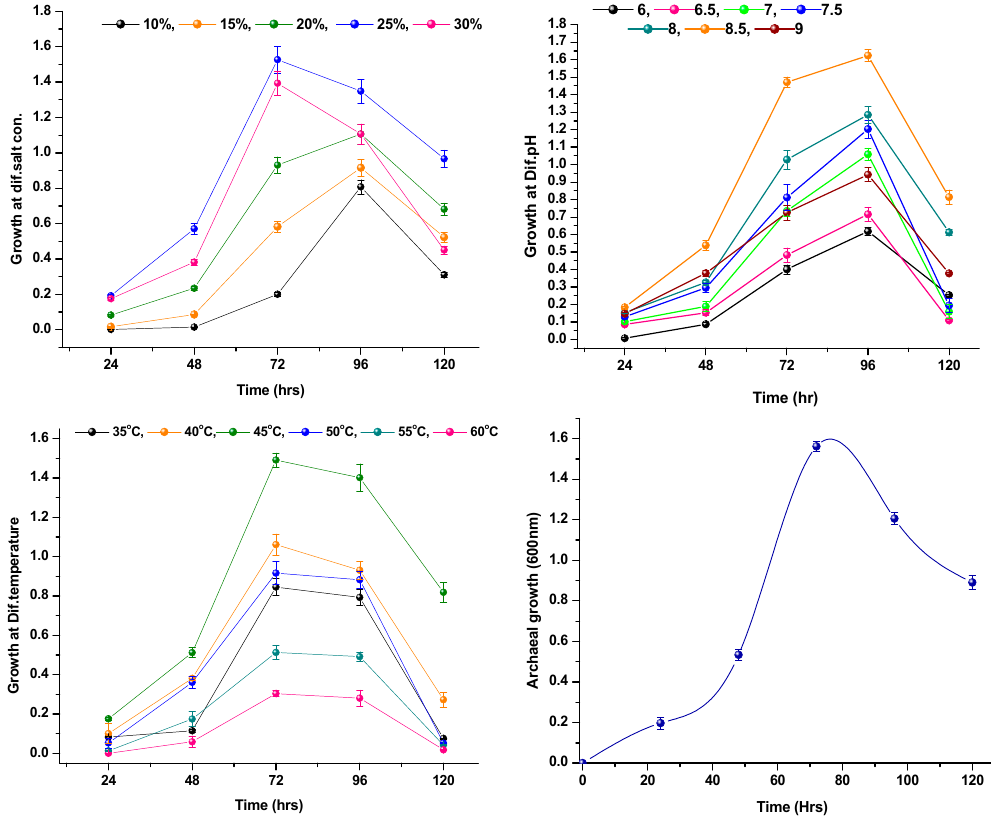
Figure 5. Optimal growth condition of marine archaea Halococcus AMS12.